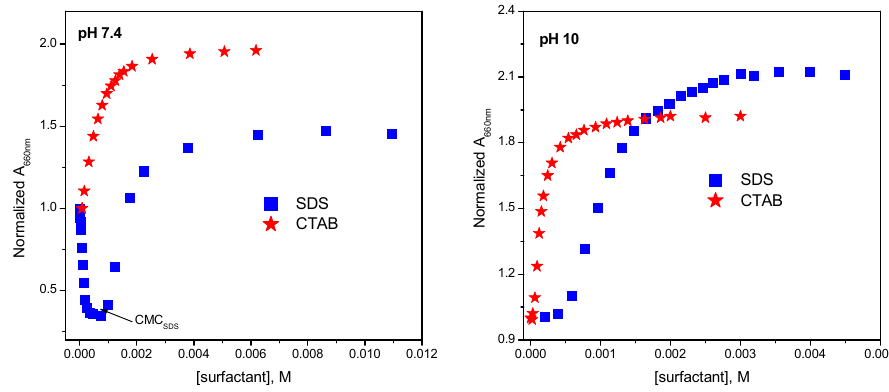
Figure 4. Variation of the monomer normalized absorbance at 660 nm with SDS and CTAB concentration at pH 7.4 and pH 10. (The figure was drawn based on references [41,42]). Erdinc et al. studied the interaction of the cationic anthracycline drug epirubicin with anionic (SDS), cationic (CTAB) and non-ionic (Triton X-100, Tween-20) surfactants by using UV-Vis absorption spectroscopy [61]. Their results indicated that in the case of SDS, epirubicin-SDS molecular complex